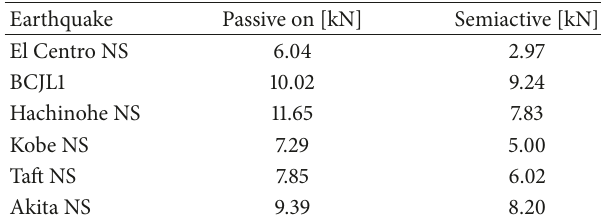
Table 3: Peak force of the